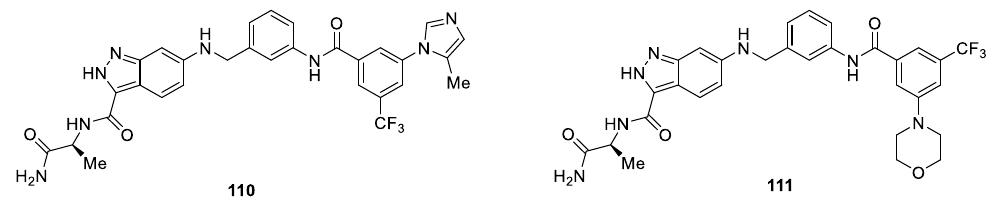
Figure 21. Chemical structures of 3-carboxamido-2 H -indazole-6-arylamide derivatives 110 and 111.